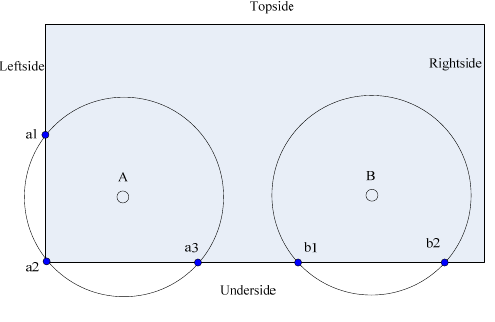
Figure 4. Sink A and B cross with rectangular borders.